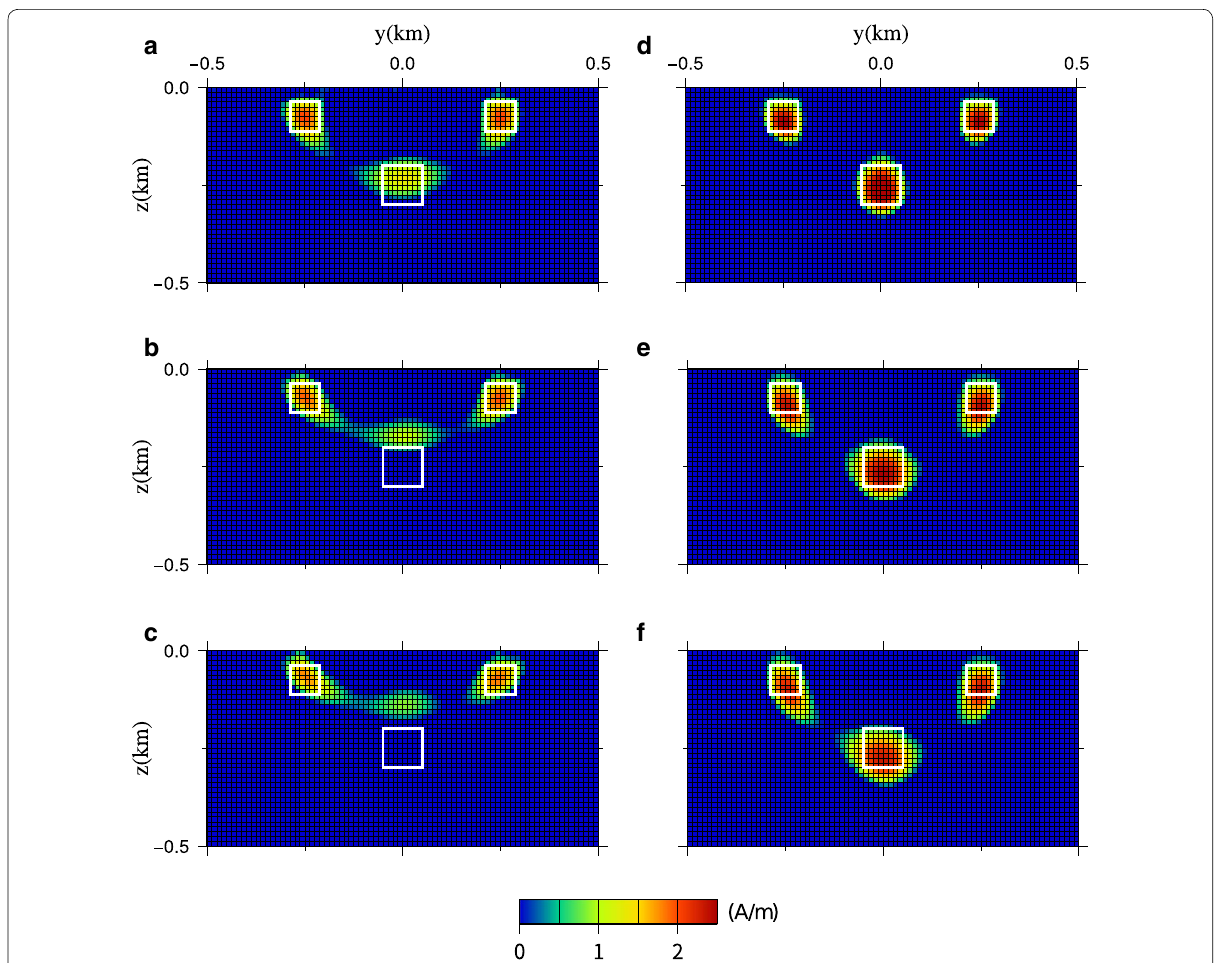
Fig. 13 Optimal models derived by L1–L2 norm combined regularized inversion. Optimal models derived by L1–L2 norm combined regularized α S 1 0.96 and σ 0 of a 0.5, b 5.0, and c 10.0 nT, with inversion with ˆ = of the magnetized blocks of the true